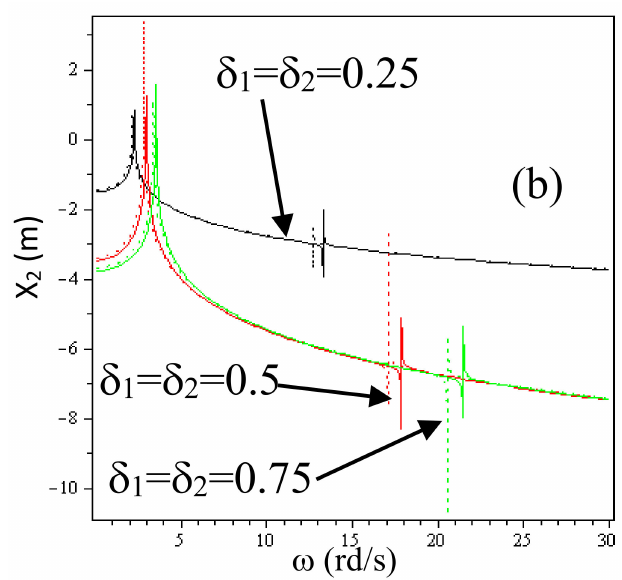
Figure 4. ( a ). Displacement x 1 versus the circular natural frequency ω . ( b ). Displacement x 2 versus the circular natural frequency ω . Superposition of the solution by the RPM approach (_____) and the exact solution (——).